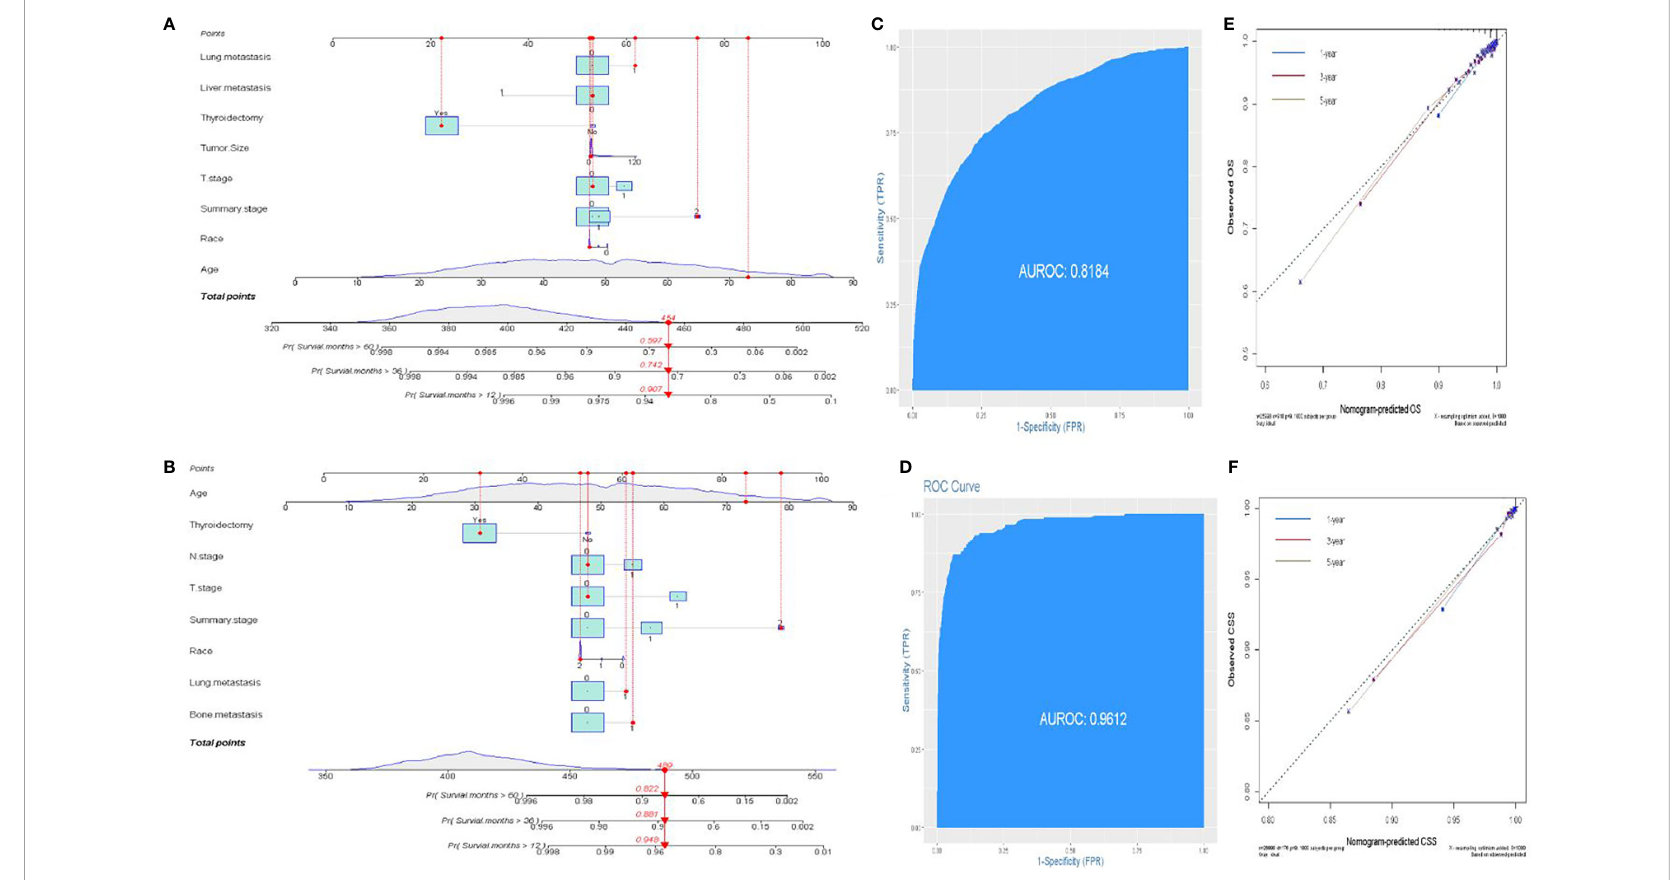
FIGURE 5 Establishment of prognostic nomograms. (A, B) Nomogram predicting the probability of OS and CSS. (C, D) The ROC curve of the nomogram with OS and CSS. (E, F) Calibration curves of the nomogram for the probability of OS and